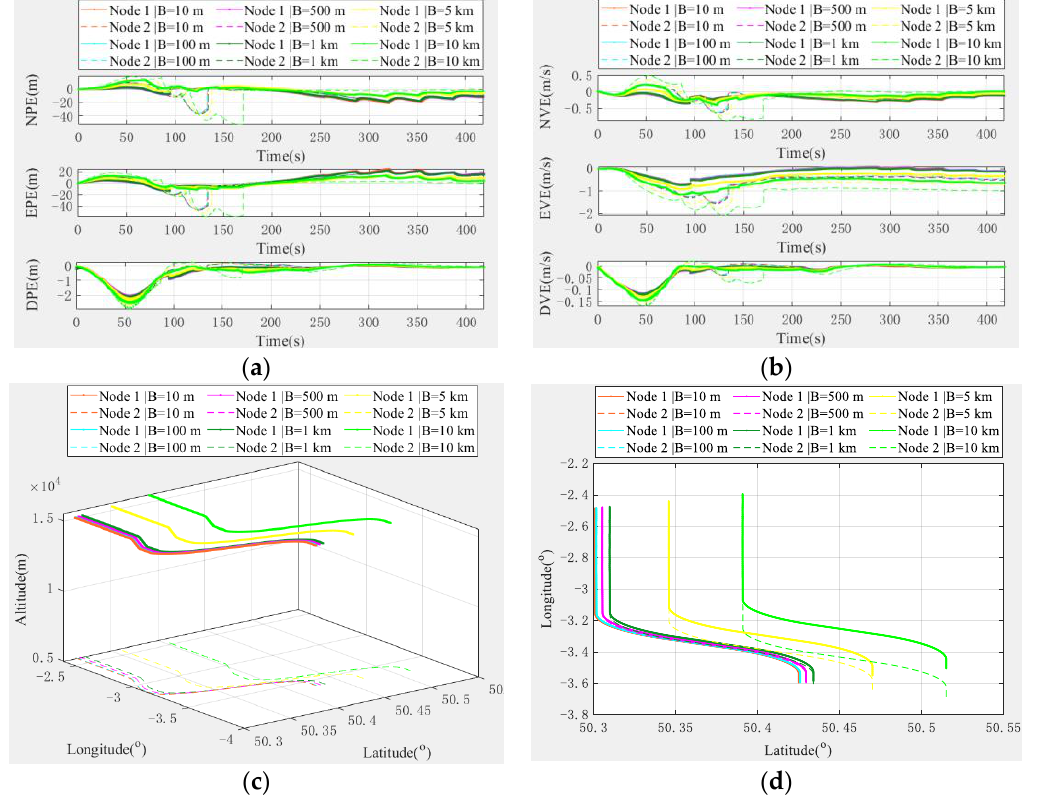
Figure 7. Joint navigation and positioning error curves at different baseline intervals. ( a ) Position travel curve, ( b ) velocity error curve, ( c ) 3D trajectory error curve, and ( d ) 3D projection error curve.